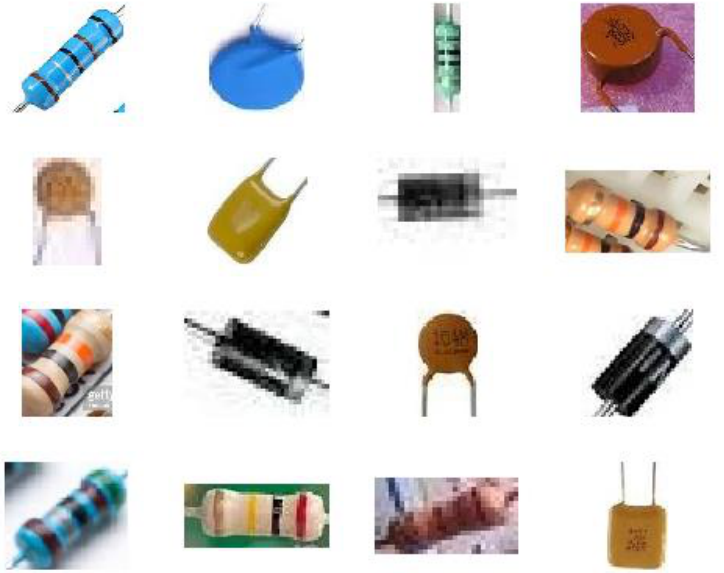
Figure 7. Classified dataset example [23].